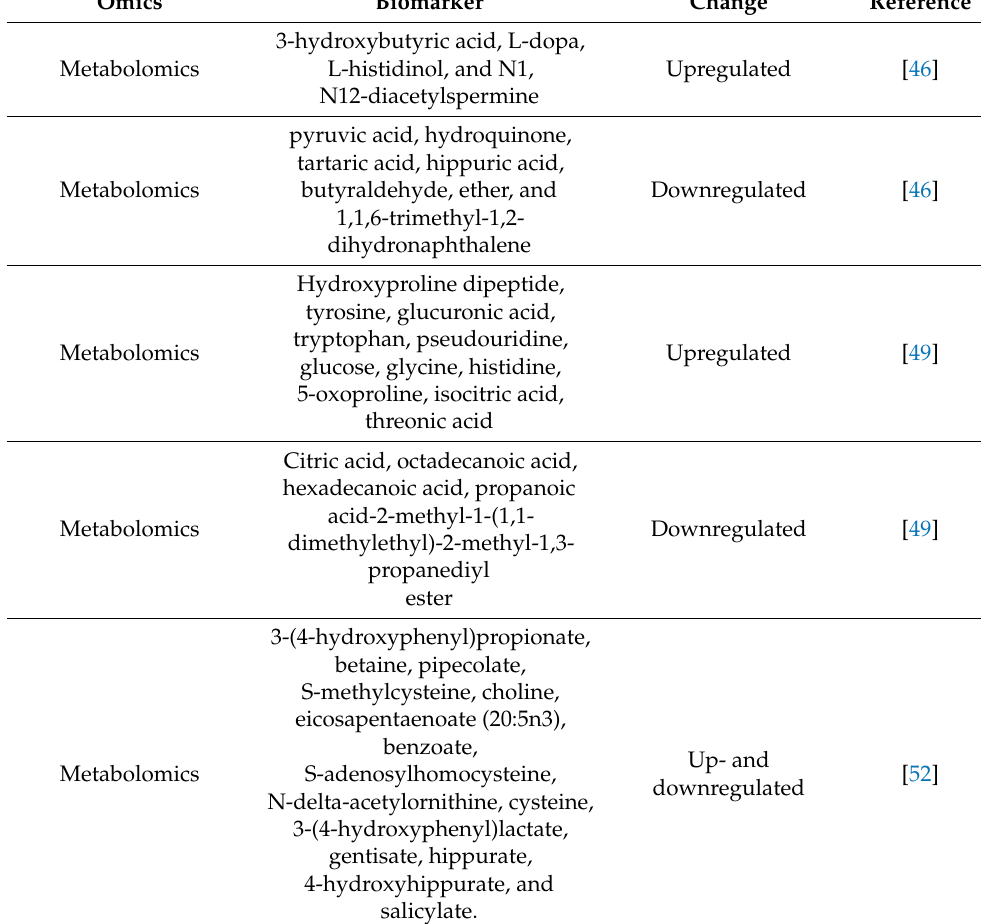
Table 2. Main biomarkers found in urine samples of CRC patients with